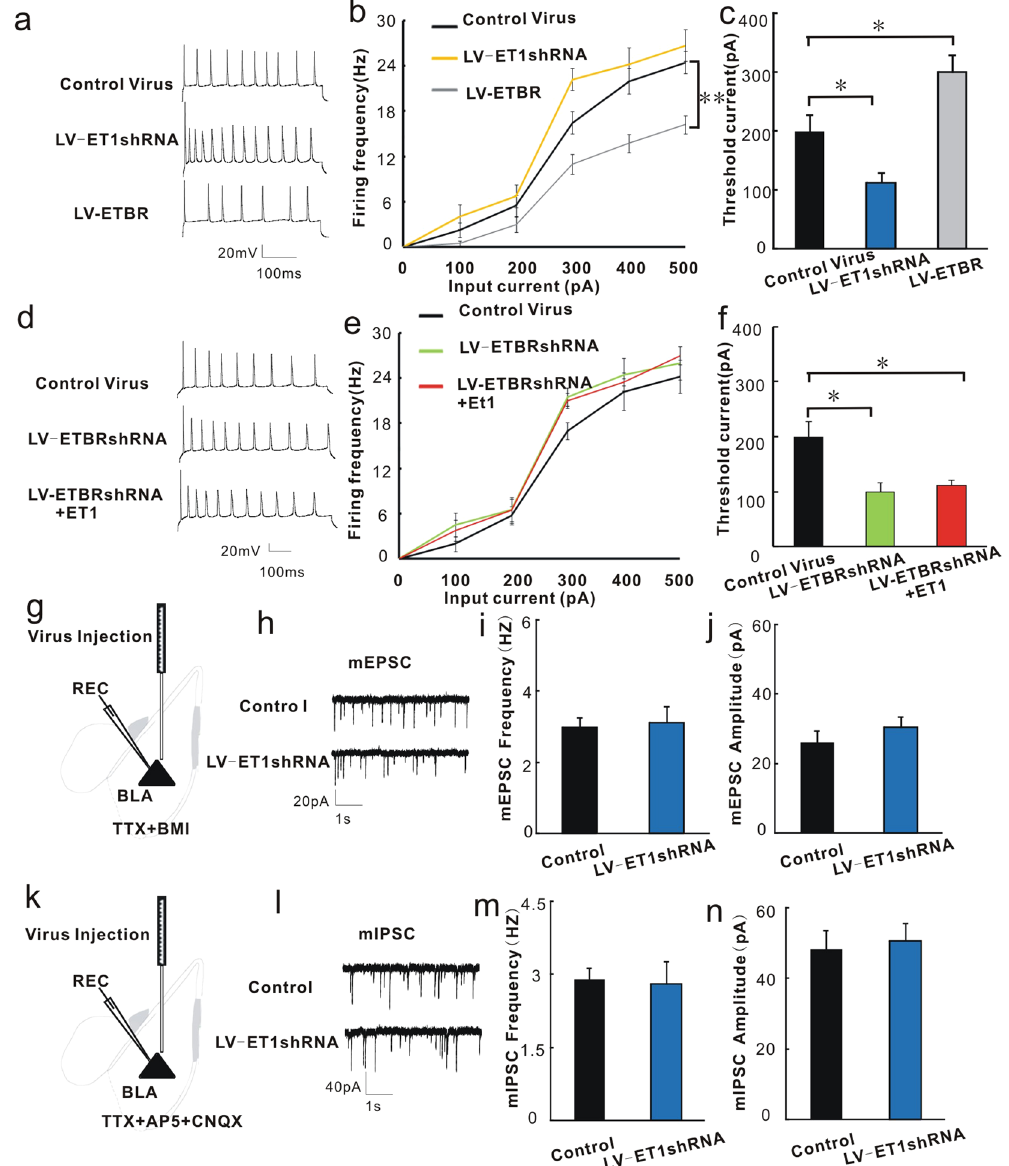
Figure 5. ET1 directly regulates the excitability of BLA pyramidal neurons through ETBRs. Viruses were injected into the BLA two weeks before the patch-clamp recordings. ( a ) Representative action potentials of pyramidal neurons in the BLA from mice treated with the control lentivirus, LV-ET1 shRNA and LV-ETBR. ( b ) Summary histogram of the firing frequency of action potentials. ( c ) Summary histogram of the threshold current for action potential generation. ( d ) Representative action potentials of pyramidal neurons in the BLA from slices treated with the control lentivirus, LV-ETBR shRNA and LV-ETBR shRNA + ET1 (probing with 300 pA current). ( e ) Summary histogram of the firing frequency of action potentials. ( f ) Summary histogram of the threshold current for action potential generation (n = 8/group). ( g ) Schematic illustration of the injection sites for virus in the BLA and recording sites for the mEPSCs of BLA pyramidal neurons. ( h ) Representative mEPSC traces of BLA pyramidal neurons treated with control lentivirus or LV-ET1 shRNA. ( i ) Summary histogram of the effect of LV-ET1 shRNA on the mEPSC frequencies of BLA pyramidal neurons. ( j ) Summary histogram of the effect of LV-ET1 shRNA on mEPSC amplitudes of BLA pyramidal neurons (n = 6/group). ( k ) Schematic illustration of the injection sites for LV-ET1 shRNA in the BLA and the recording sites for the mIPSCs of BLA pyramidal neurons. ( l ) Representative mIPSC traces of BLA pyramidal neurons treated with control lentivirus or LV-ET1 shRNA. ( m ) Summary histogram of the effect of LV-ET1 shRNA on mIPSC frequencies of BLA pyramidal neurons. ( n ) Summary histogram of the effect of LV-ET1 shRNA on mIPSC amplitudes of BLA pyramidal neurons (n = 6/group). Triangles ( ▴ ) represent pyramidal neurons. * P < 0.05, two-way ANOVA test with one factor as repeated measure for 5b and 5e, one-way ANOVA with post hoc test for 5c and 5f, student’s t test for 5m-5i and